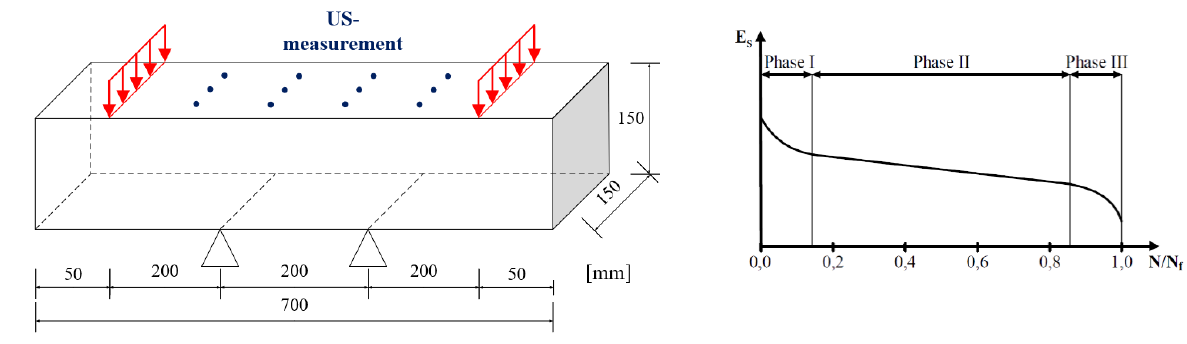
Figure 7. Schematic test arrangement for US (left) and course of sti ff ness development (right